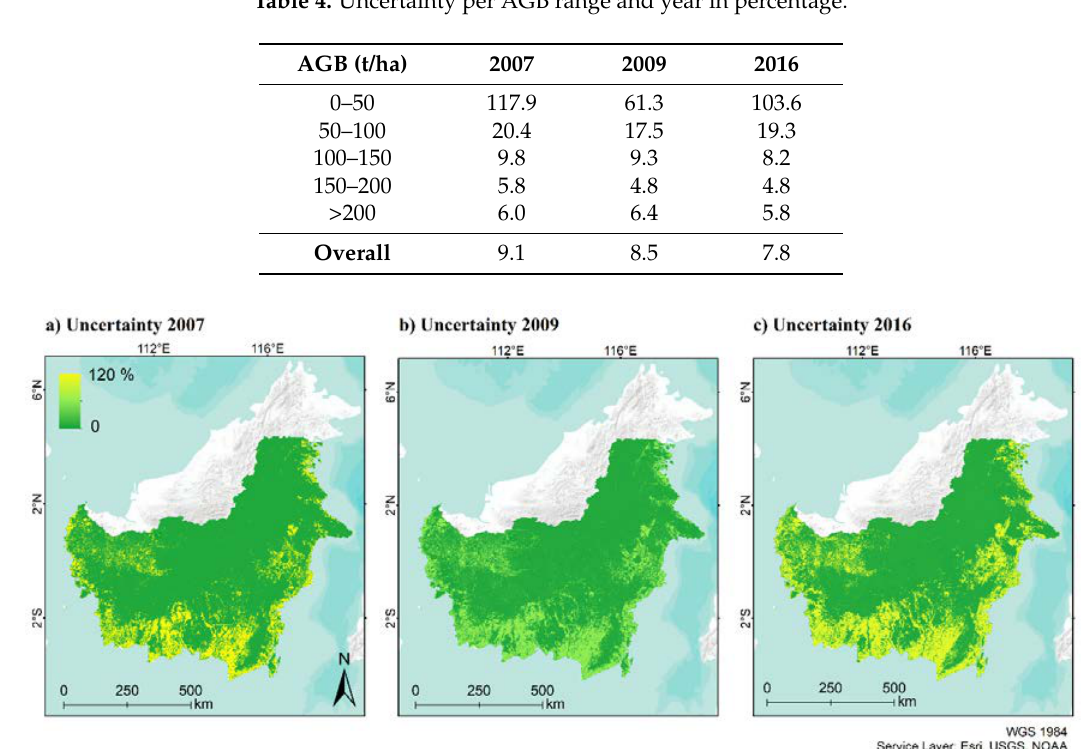
Figure 8. Uncertainty maps per AGB range for each year showing highest errors in low biomass ranges.